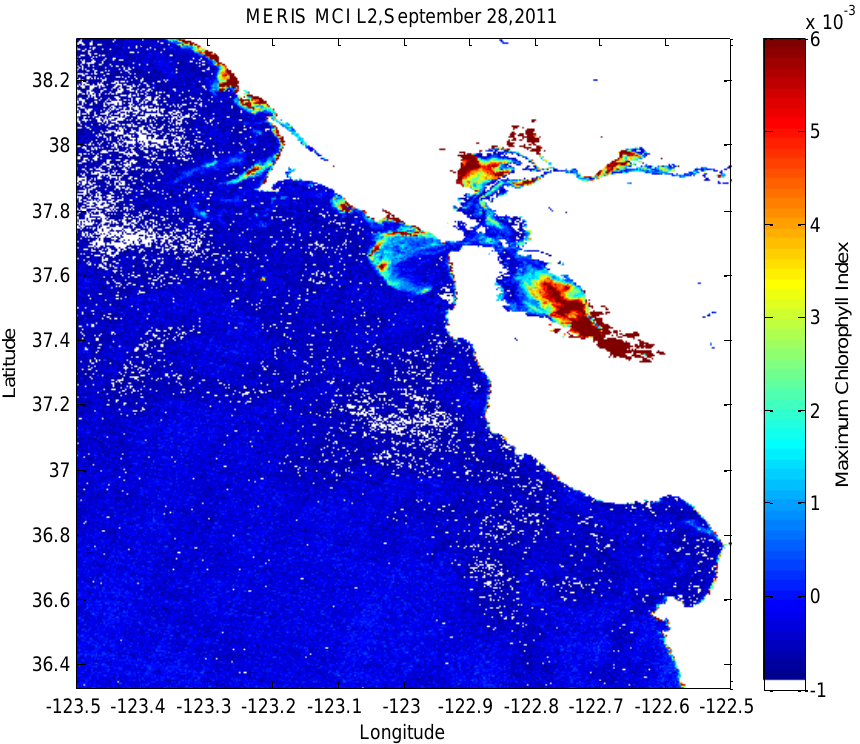
Figure 2. Bloom-like events in the northern part of Monterey Bay and San Francisco Bay through MERIS on 28 September 2011.